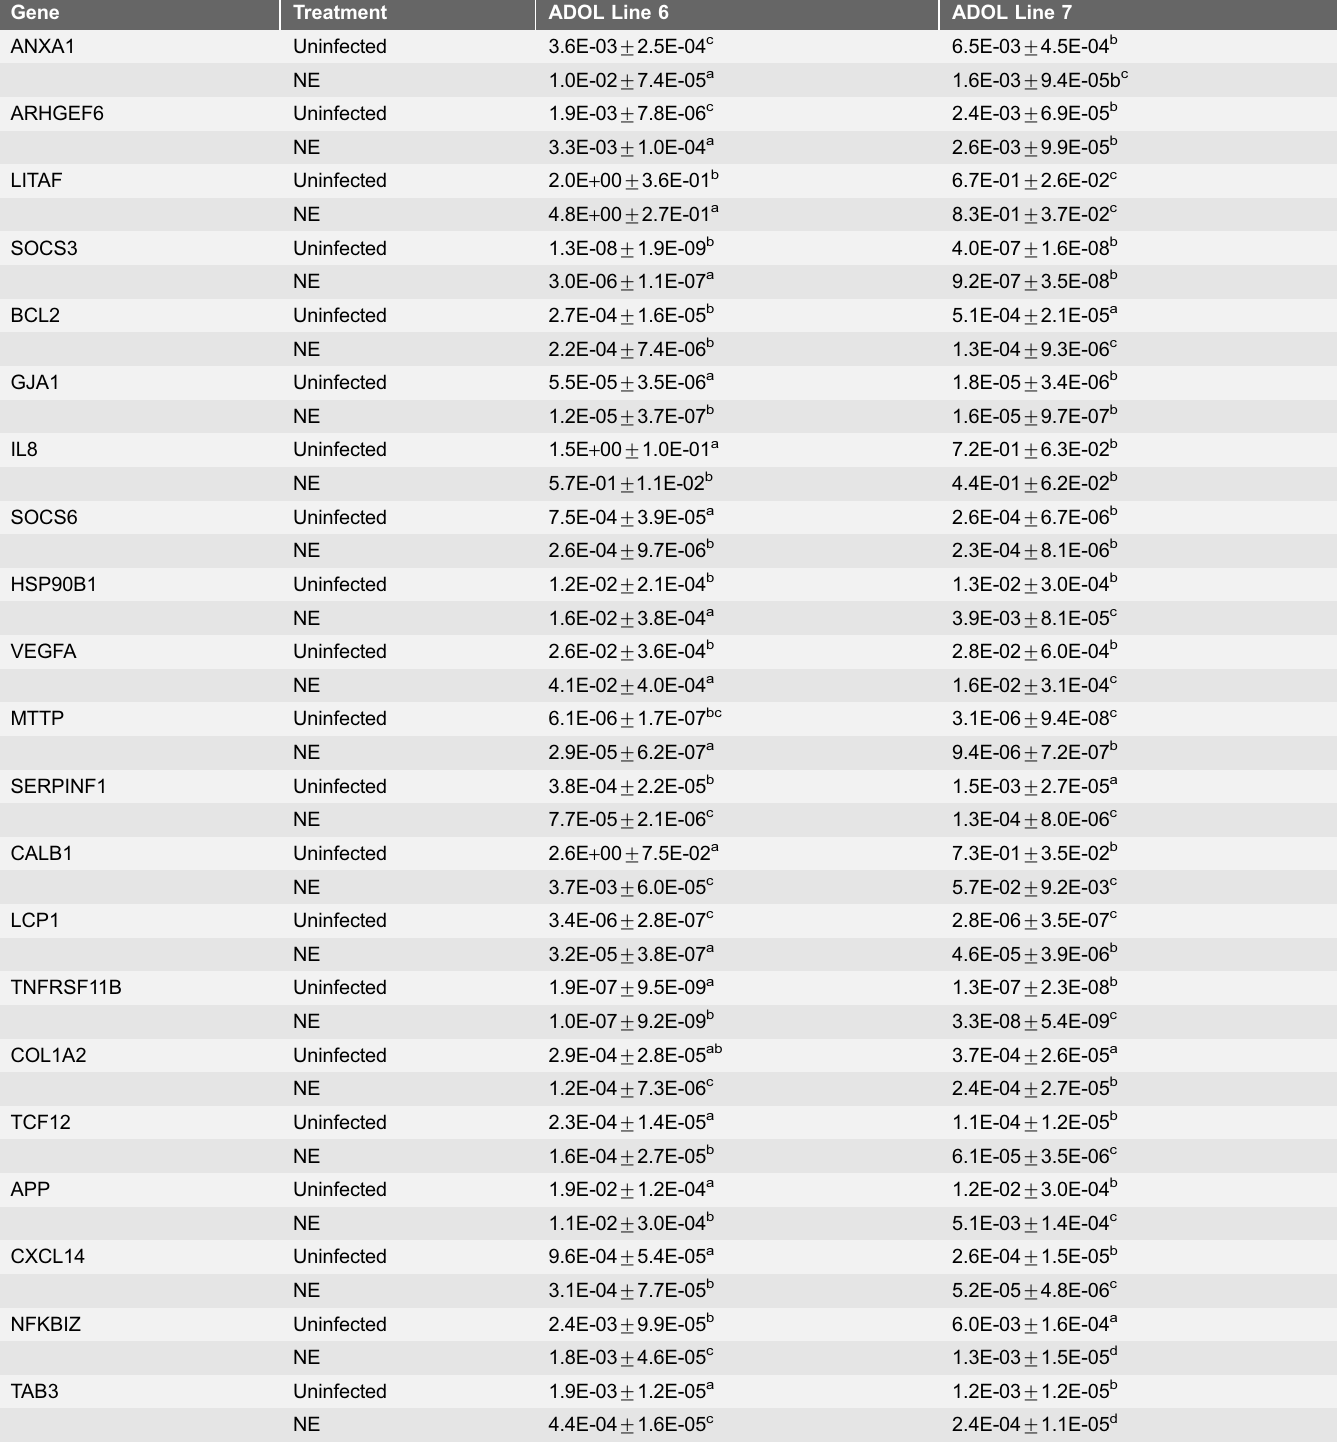
Table 6. Immune-related intestinal IEL transcript levels in uninfected and in C. perfringens / E. maxima co-infected ADOL line 6 and line 7 chickens.